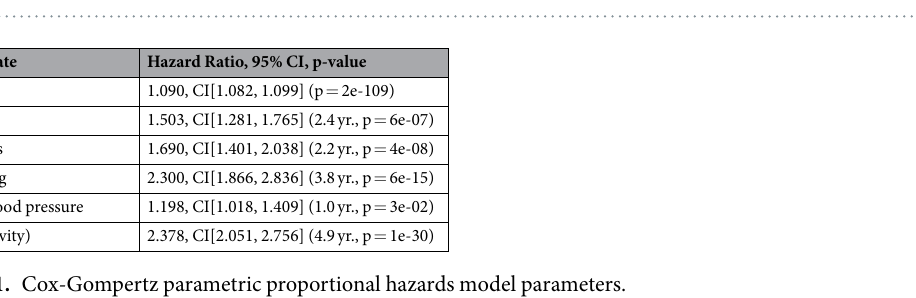
Figure 2. Performance of the biological age models to distinguish between the longer- and the shorter-living individuals illustrated with Kaplan-Meier survival curves. Each participant was classified into the “high-” and the “low-” risks groups according to the deep convolutional neural network CNN_Age ( A ), the multivariate regression REG_Age ( B ), and the unsupervised PCA_Age ( C ) models. The p-values characterize the survival curves separation significance.